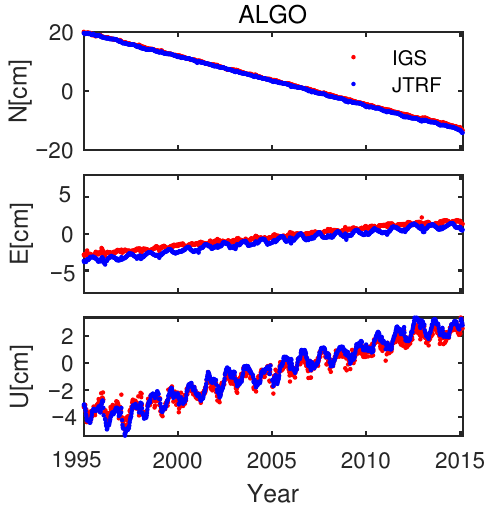
Figure 8. The IGS and JTRF2014 station position time series of the station ALGO. The average values of the IGS solutions are taken from individual